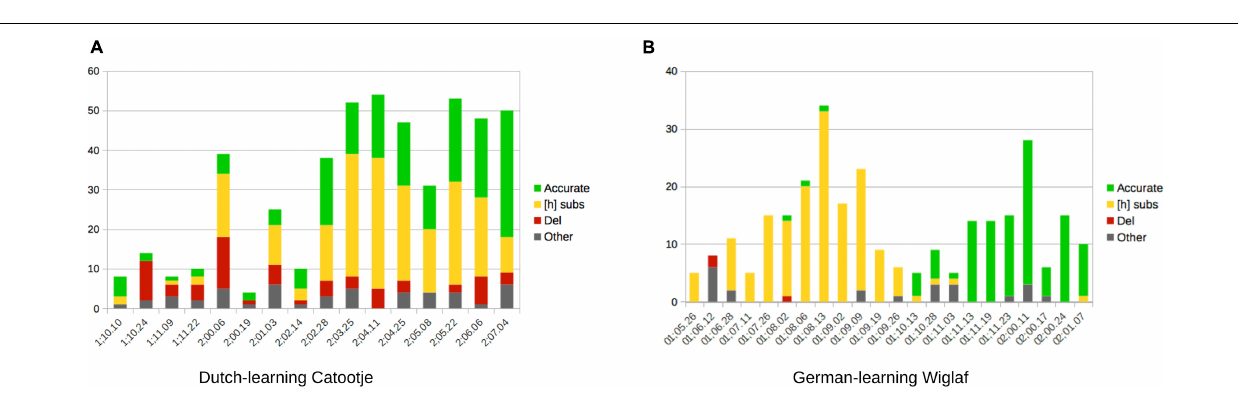
FIGURE 3 | Variable vs. categorical behaviors in the emergence of | ö | . (A) Dutch-learning Catootje. (B) German-learning